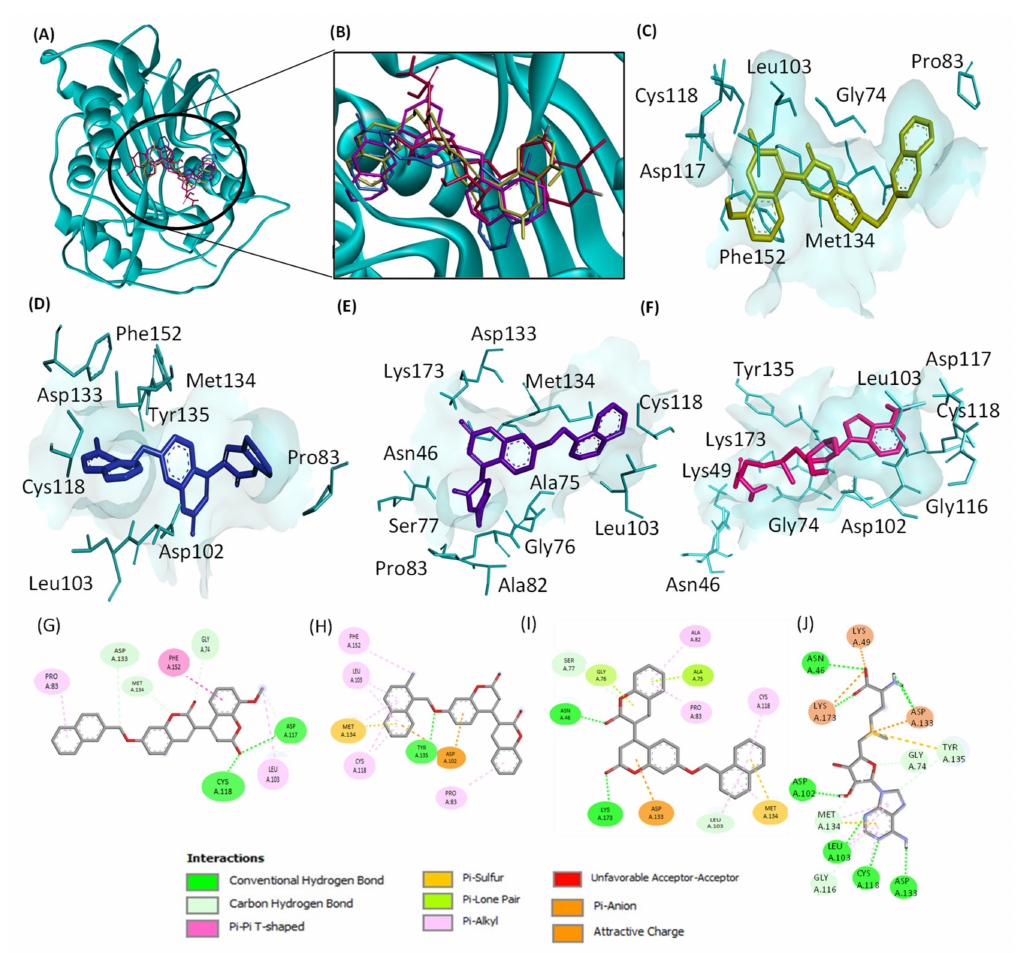
Figure 5. 3D and 2D views of the interactions of the hits with SARS-CoV-2 nsp16 binding pocket (PDB: 6W4H) determined by molecular docking. ( A ) Binding of the three hits and the control SAM. ( B ) Zoomed view of the 3D structure of SARS-CoV-2 nsp16. ( C – F ): interactions of the amino acids in the binding pocket with ZINC12880820 (gold), ZINC2121012 (blue), ZINC2129028 (purple), and the control SAM (red), respectively. ( G – J ) are 2D views of ( C – F ), respectively. The images were generated by Discovery Studio